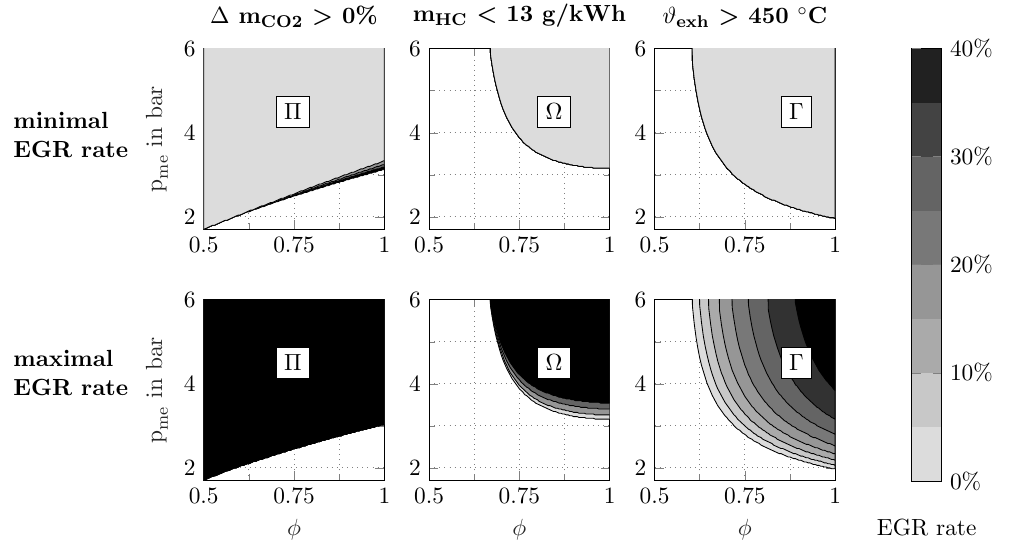
Figure 11. Each of the three criteria introduces a feasible set spanned by the three input variables brake mean effective pressure p me , equivalence ratio φ , and EGR rate x EGR